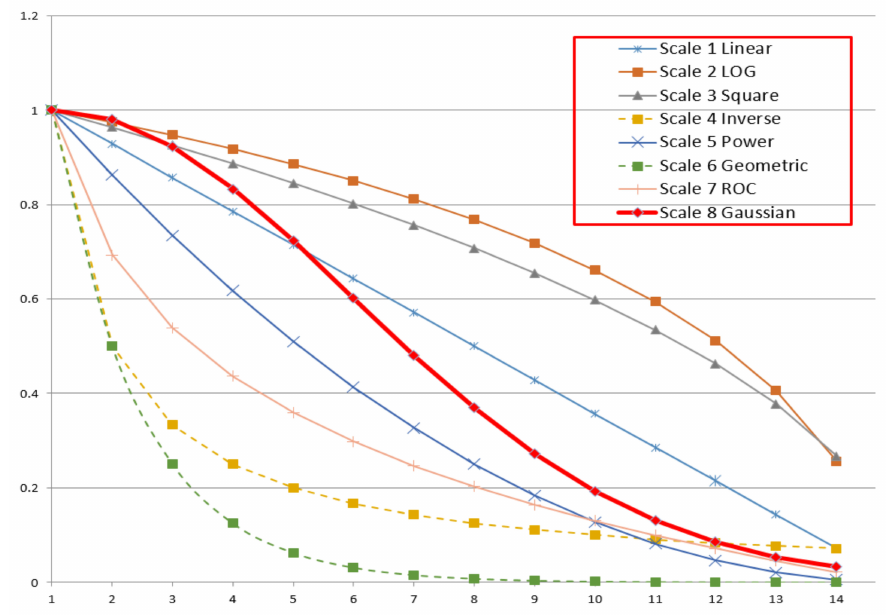
Figure 1. Curves of